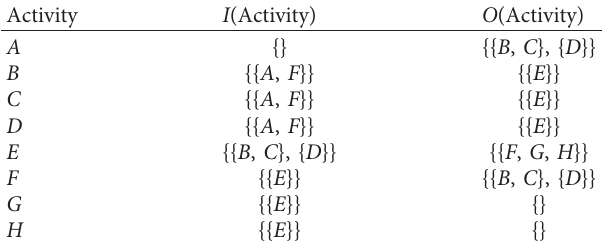
Table 1: Causal matrix of the process model.